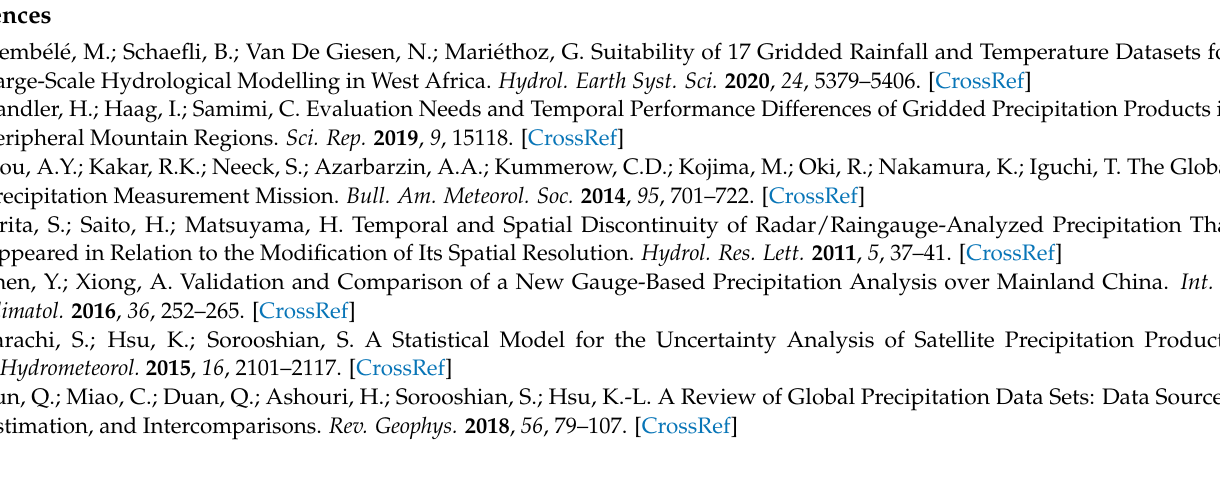
x-axis) used as forcing in the VIC model. Each boxplot has 26 values for each streamflow gauging station; Figure S10: Kling-Gupta efficiency of daily streamflow over the calibration period (2014–2019) for forty-four combinations of eleven precipitation datasets (y-axis) and four temperature datasets (subplots on x-axis) used as forcing in the VIC model. Each boxplot has 26 values for each streamflow gauging station; Figure S11: Average of the logged transformed (E_logNSE) and modified (E_absNSE) Nash-Sutcliffe efficiencies for the 26 daily streamflow simulations during (left) the calibration period and (right) the validation period for forty-four combinations of 11 precipitation datasets (y-axis) and 4 temperature datasets (x-axis) employed as forcing in hydrological